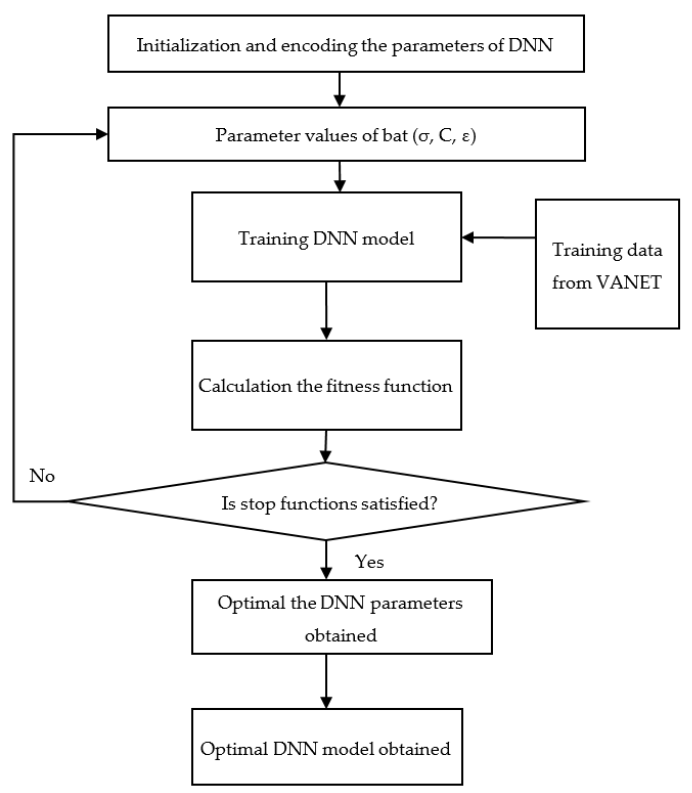
Figure 2. Deep neural network (DNN) architecture.